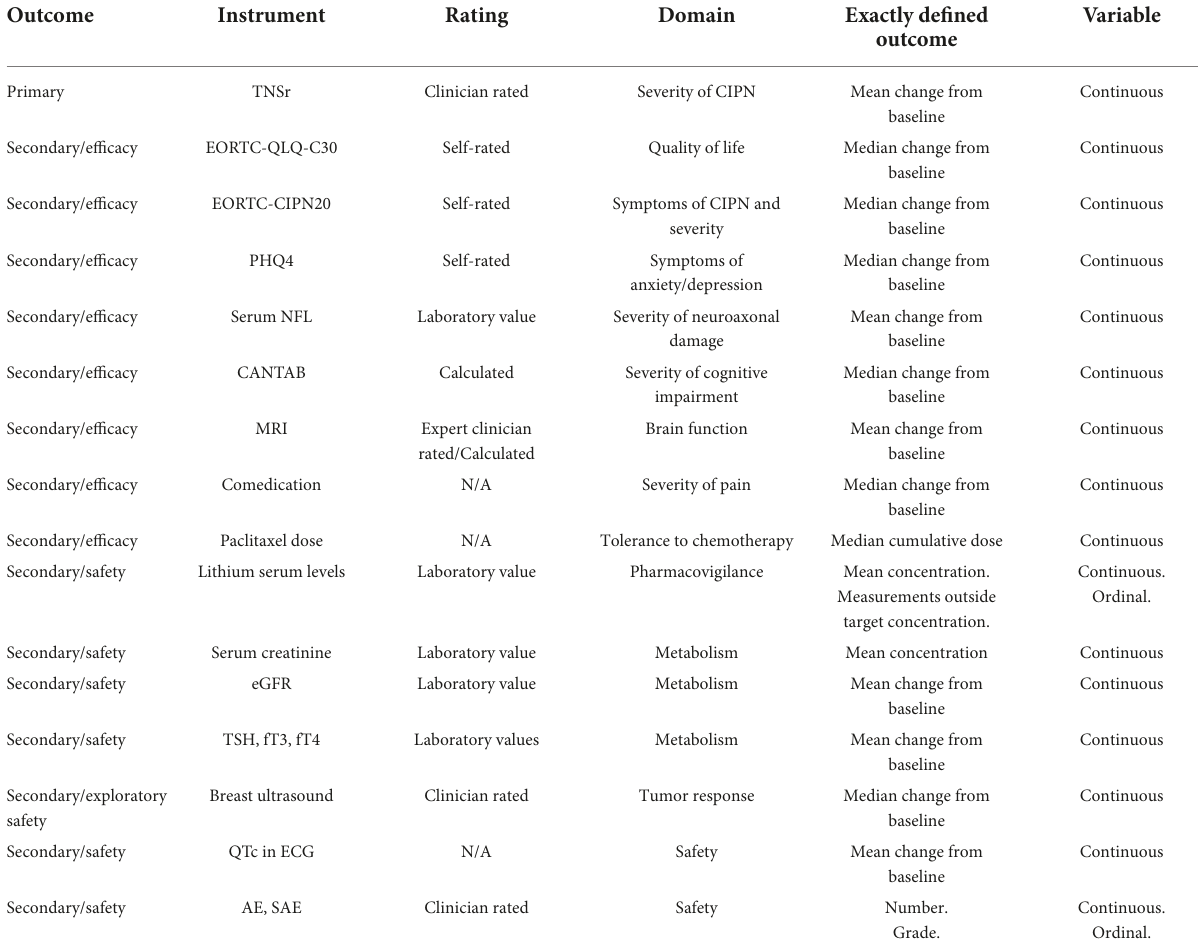
TABLE 4 Characteristics and definitions of main